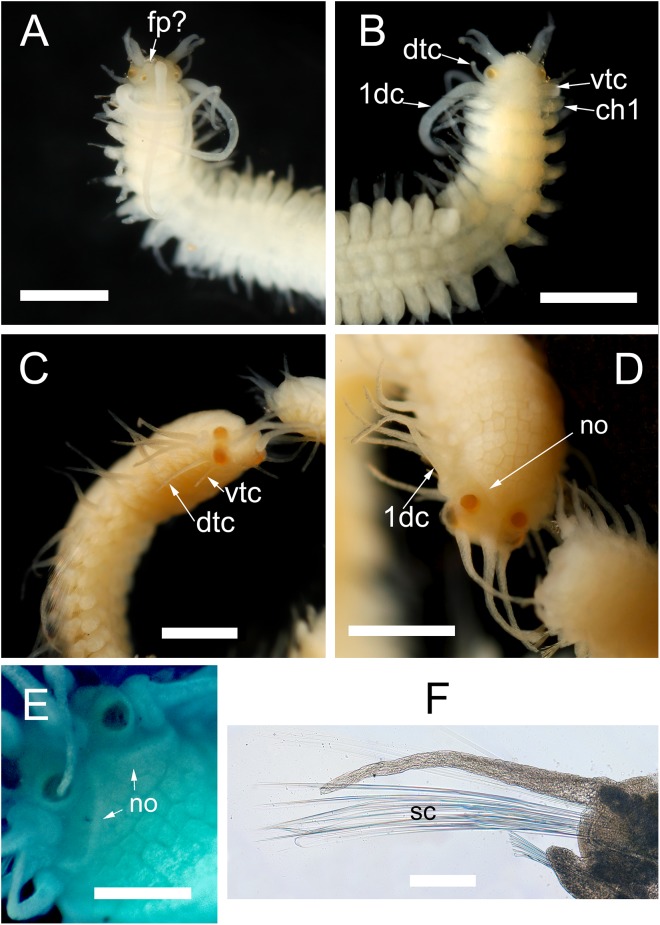
Proceraea exoryxae sp. nov. morphology of epitokes.Anterior end of male stolon [MNCN 16.01/17721]: (A) dorsal view; (B) ventral view. Anterior end of female stolon [MNCN 16.01/17722]: (C) anteroventral view; (D) dorsal view; (E) detail of prostomium showing the nuchal organs (stained with methyl blue). (F) Mid-body parapodia of female stolon showing the swimming chaetae [MNCN 16.01/17722]. dtc, dorsal tentacular cirri; vtc, ventral tentacular cirri; 1dc, first dorsal cirri; ch1, chaetiger 1; fr, frontal process; no, nuchal organs; sc, swimming chaetae. Scale bars A–D = 0.5 mm, E, F = 100 μm.